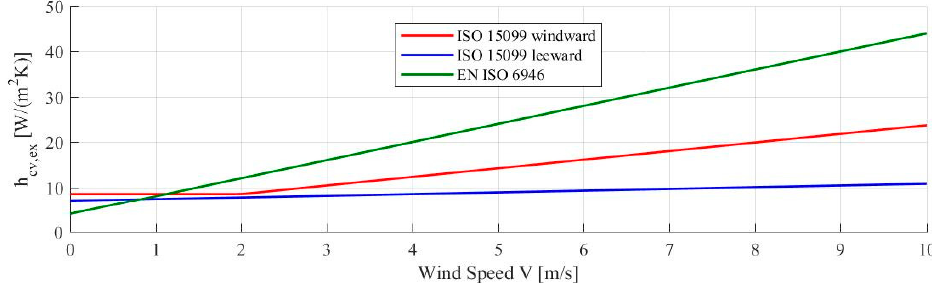
Figure 7. Comparison of h cv,ex formulas from ISO 15099 [27] and EN 6946 [21].